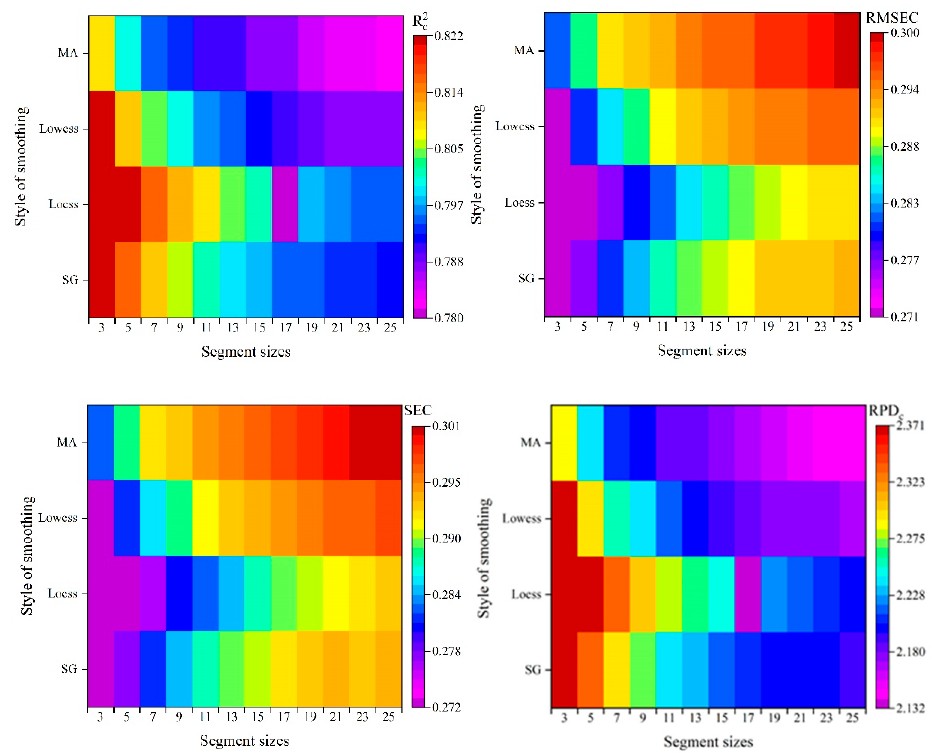
Figure 5. Results of PLS model for various segment sizes. MA: moving average; SG: Savitzky-Golay.